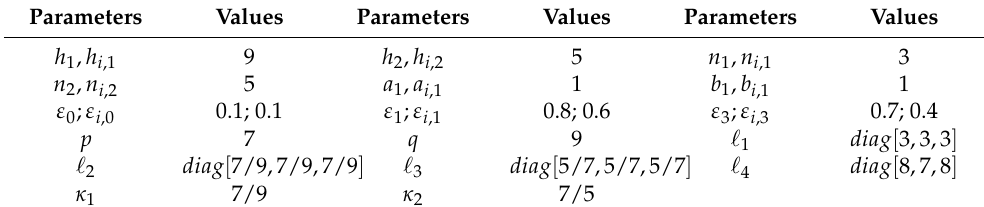
Table 2. Parameter values. Parameters